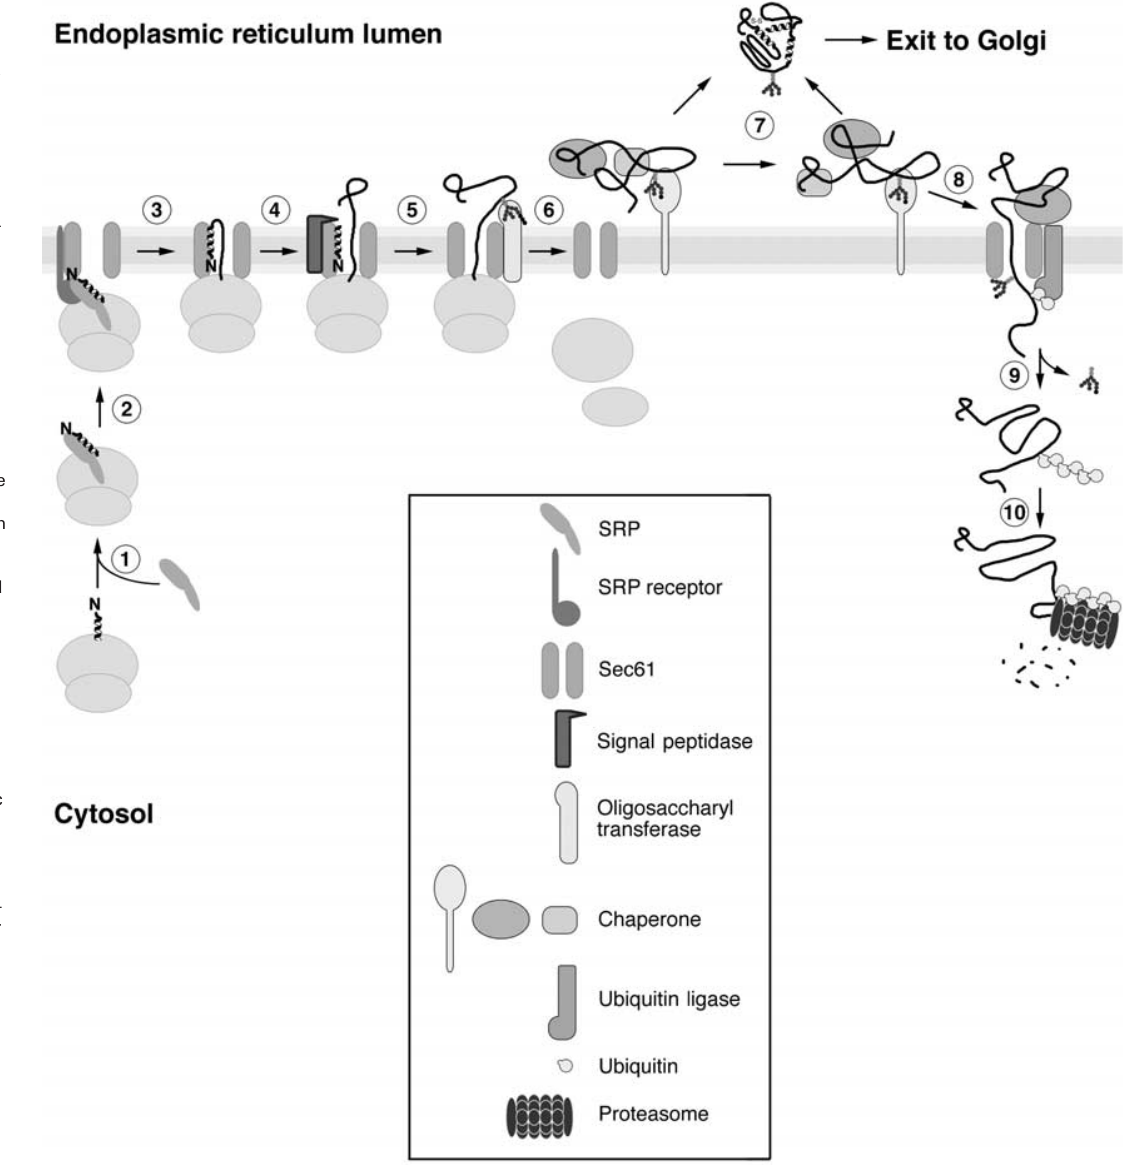
Into and out of the ER. (1) Proteins are targeted to the ER by interaction of the hydrophobic signal sequence with signal recognition particle (SRP) and (2) of the complex to the SRP receptor. (3) The nas- cent polypeptide is translocated through the Sec61 transloca- tion pore. Concomi- tantly, (4) the signal may be cleaved by signal peptidase and (5) the protein may be glycosylated by oligosaccharyltrans- ferase. (6) Chaper- ones interact with the as yet unfolded polypeptide. (7) Upon folding into the na- tive conformation, the protein is released to exit the ER. (8) Mis- folded proteins are kept back and even- tually retrotranslo- cated via the Sec61 translocation pore into the cytoplasm. (9) The retrotranslo- cated protein is ubi- quitinated by specific ubiquitin ligases and glycans are removed by a cytosolic N-gly- canase. (10) The ubiquitin-tagged pro- tein is a substrate for degradation by the cytosolic protea-